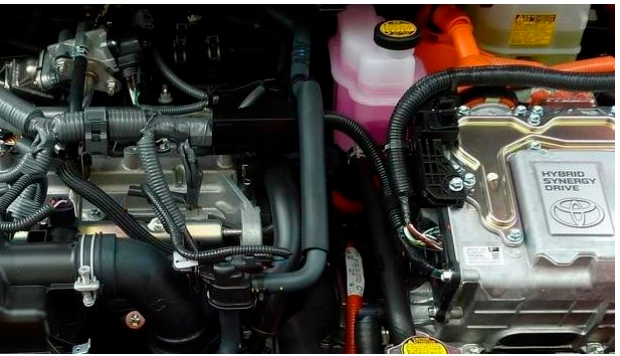
Figure 1. Hybrid powertrain of a car (Source: https://hyperauto.ru/articles/poleznaya-infor-